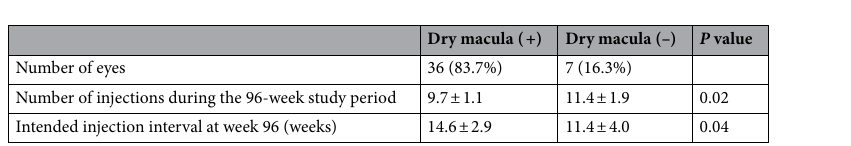
Figure 5. Intended injection intervals at weeks 52 and 96 in 43 eyes with neovascular age-related macular degeneration associated with type 1 macular neovascularization treated with 3 monthly intravitreal injections of brolucizumab followed by a treat-and-extend regimen with intravitreal brolucizumab.